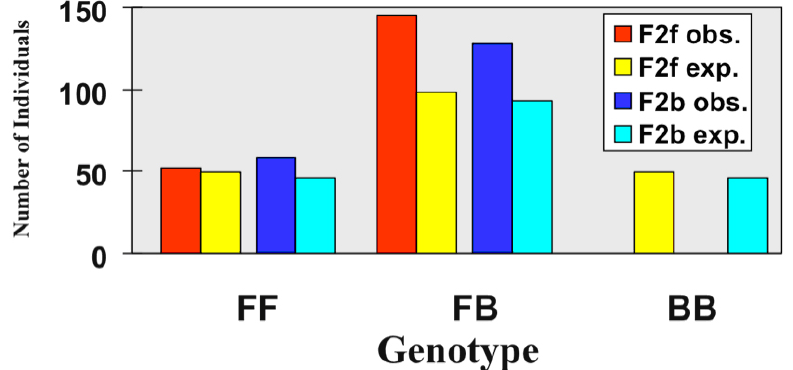
Figure 2. The observed and expected genotypic distributions at the L180 RAPD locus in I. progeny derived from crosses with either I. fulva (“F2f”) or I. fulva x I. brevicaulis F 2 brevicaulis (“F2b”) as the female parent